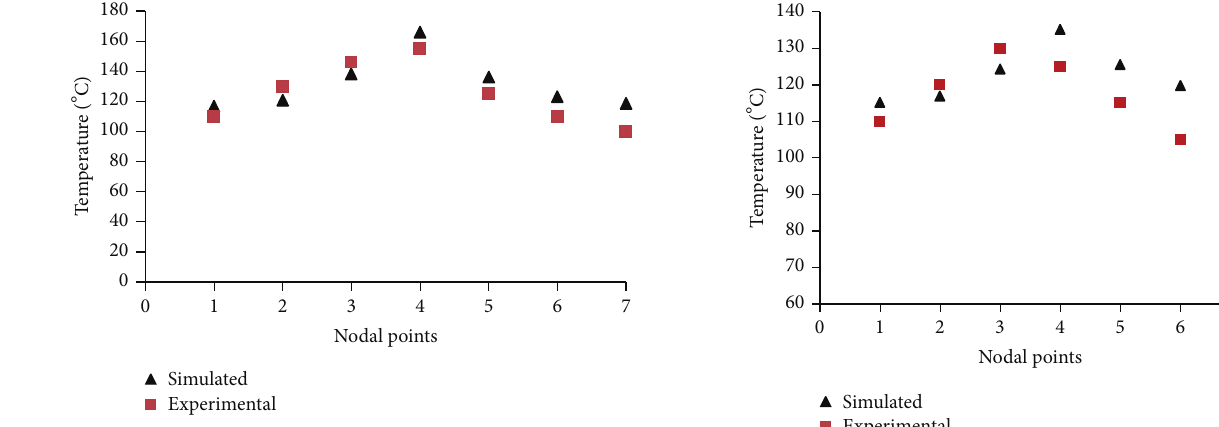
Figure 10: Temperature distribution at no